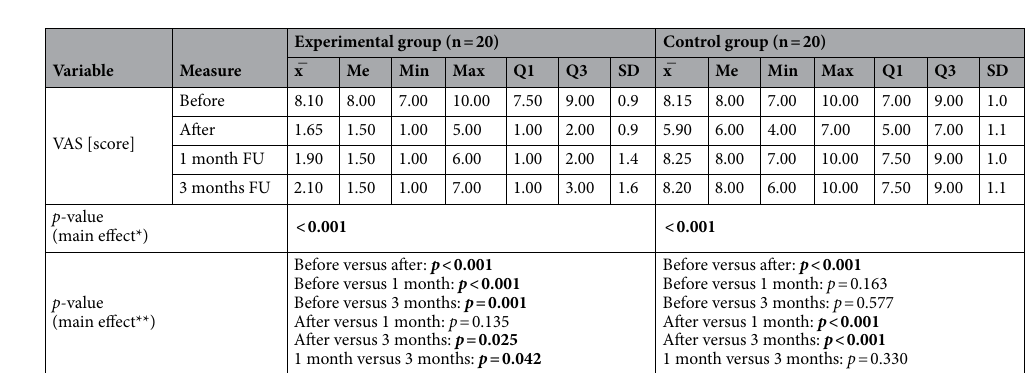
Figure 1. CONSORT flow chart of study participants.